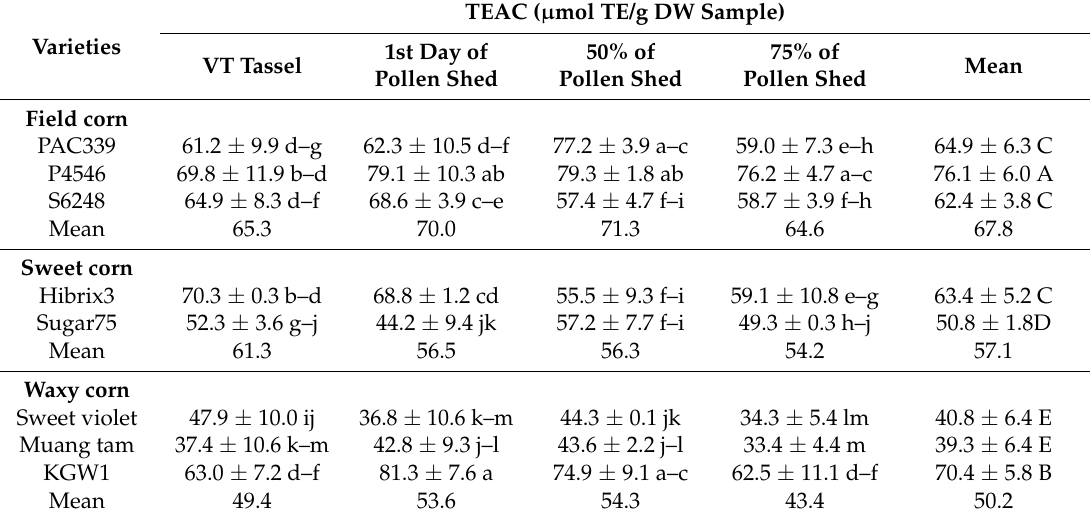
Table 6. Means for the TEAC radical scavenging capacity in the tassels of eight corn varieties evaluated at four tassel development